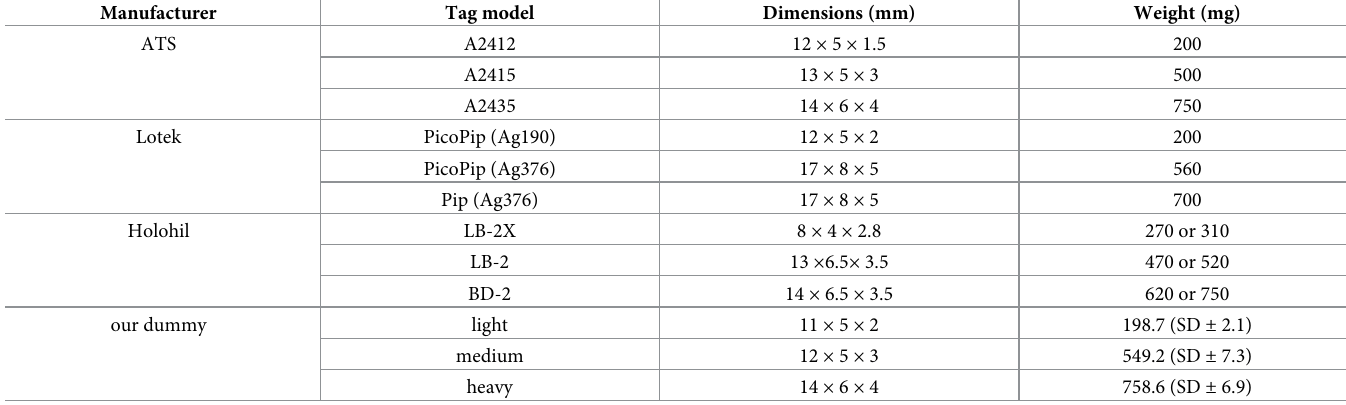
Table 1. Dimensions and weights of the three small radio telemetry tags produced by various manufacturers (ATS, lotek, and holohil) and of the 3D printed dummy tags used in the current study. Manufacturer Tag model